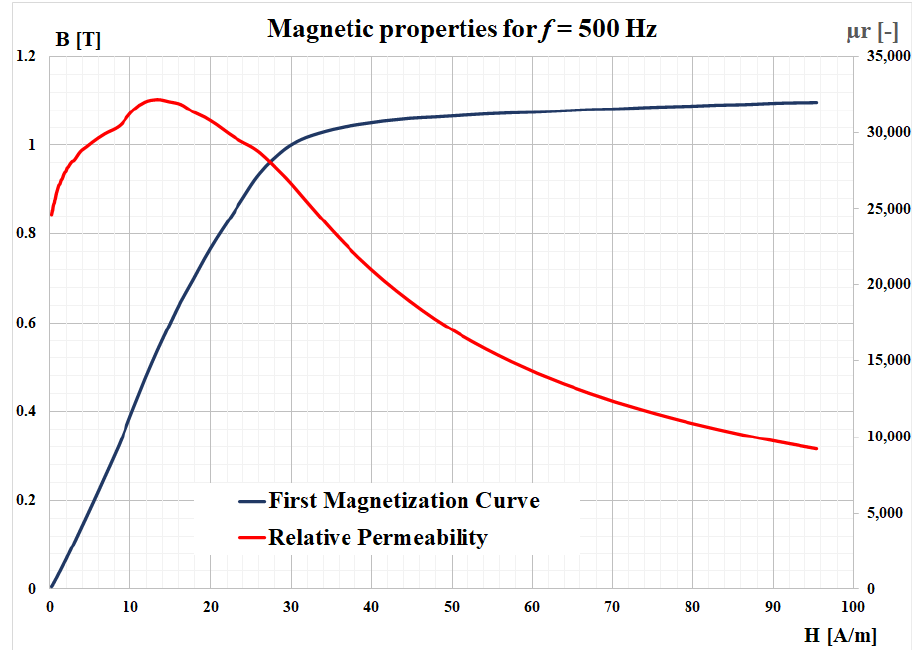
Figure 3. First magnetization curve and the relative permeability measured for the FINEMET ribbon for 500 Hz.